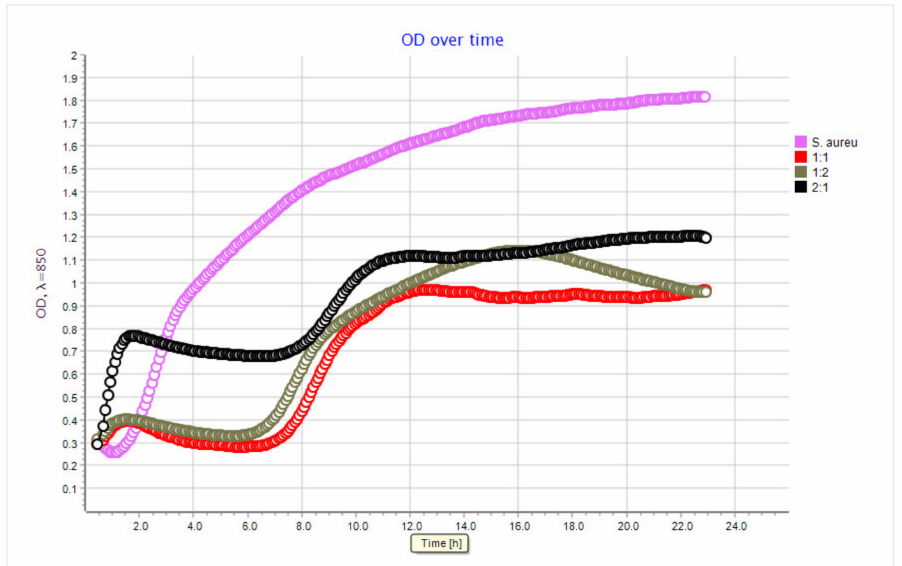
Figure 3. The influence of mixtures of S. baicalensis and Glycyrrhiza L. extracts on the growth of S . aureus .